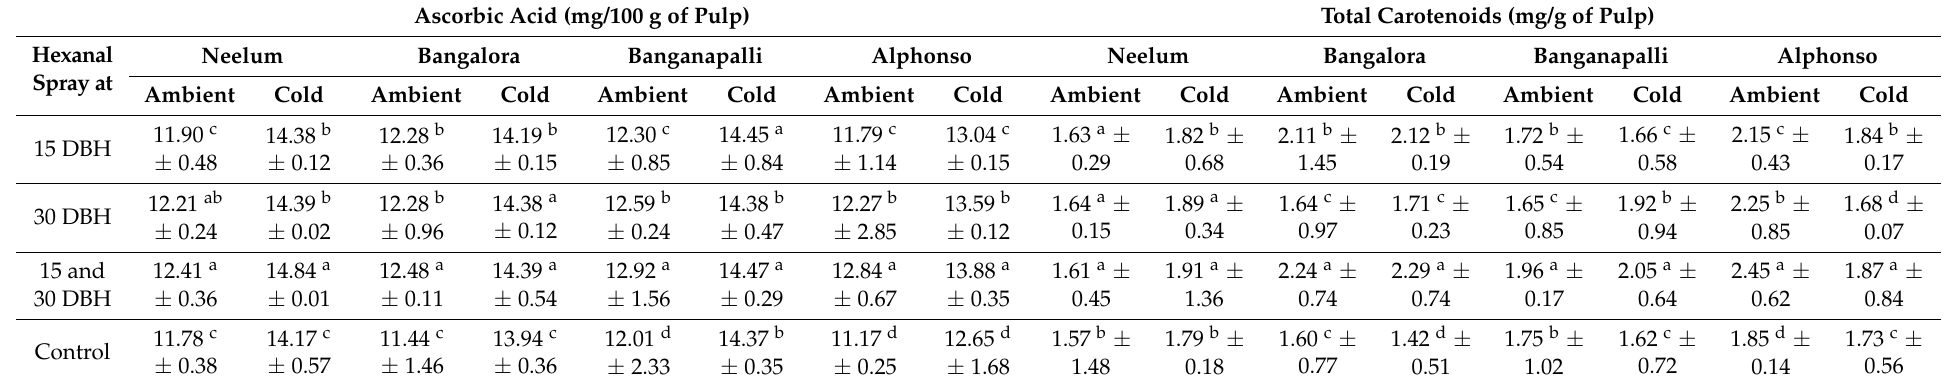
Table 3. Influence of hexanal formulation on ascorbic acid and the total carotenoids of mango cultivars under ambient and cold storage conditions. Ascorbic Acid (mg/100 g of Pulp) Total Carotenoids (mg/g of